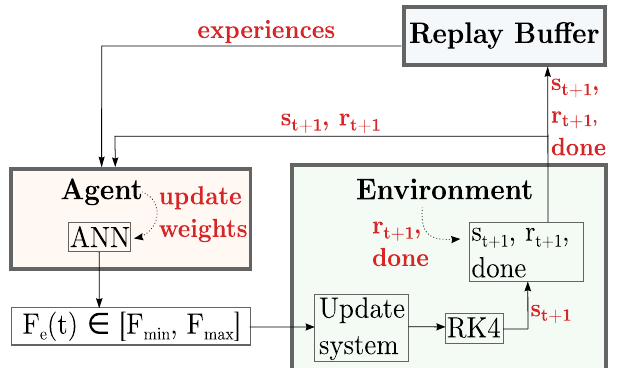
Fig. 5 Architecture of the learning loop. The agent chooses an action that updates the environment. The result is stored in a replay buffer that is used to train the agent after each action.